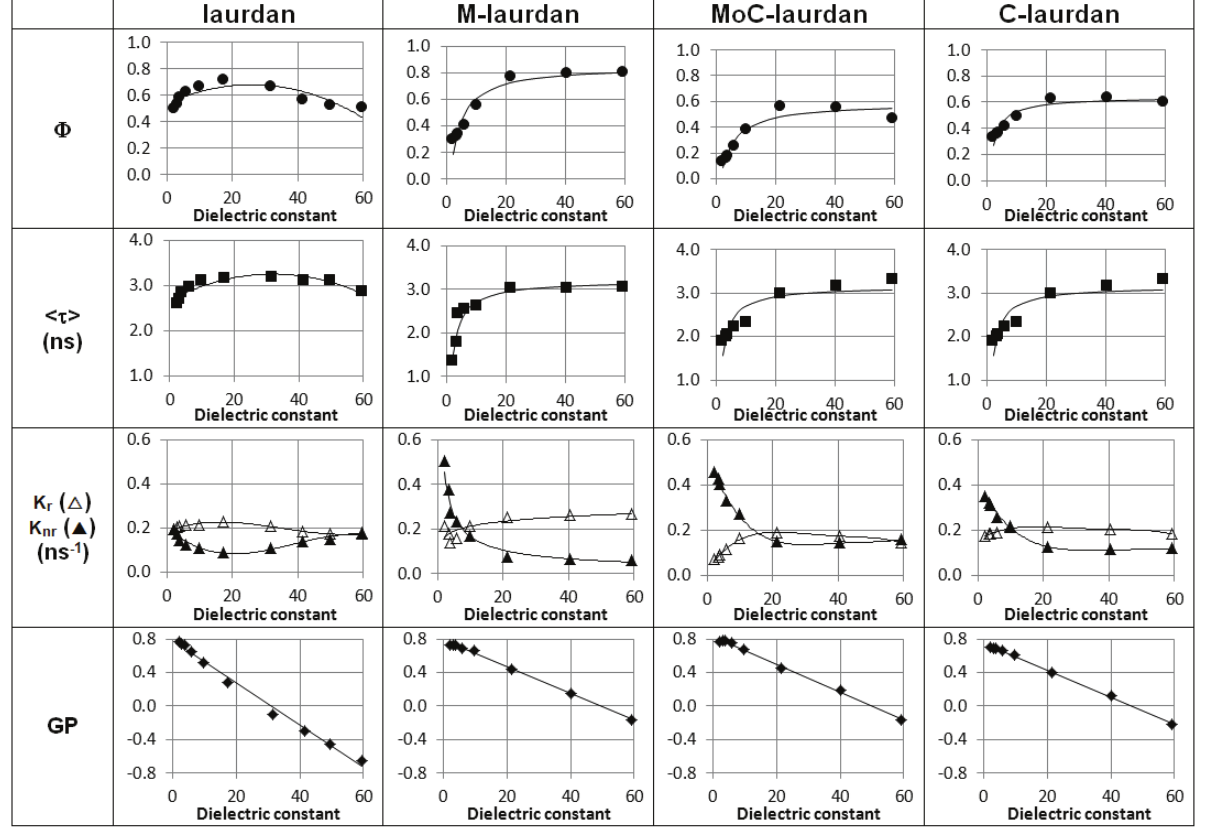
Supplemental Figure S1. Photophysical characteristics in dioxane/water mixtures. Spectroscopic properties of the four probes in dioxane/water mixtures covering a dielectric constant range from 2 to 60. Quantum yields and mean lifetimes were measured. Deexcitation constants k ( Δ ), k ( ▲ ) and Generalized Polarization GP were calculated. r nr